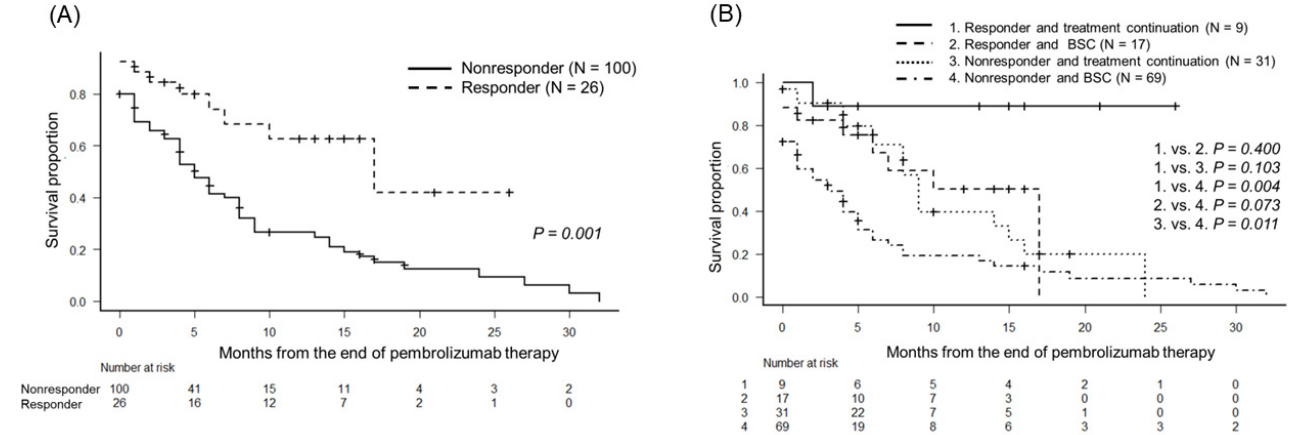
Figure 3. Kaplan–Meier estimates of overall survival (OS) in patients with metastatic urothelial carcinoma who showed tumor shrinkage (responder group) and who did not show tumor shrinkage (nonresponder group) after pembrolizumab administration. ( A ) The median OS times were 5 months and 17 months in the nonresponder and responder groups, respectively ( p = 0.001). ( B ) The enrolled patients were divided into four groups: the patients who received and did not receive third-line treatment in the responder group (groups 1 and 2, respectively) and in the nonresponder group (groups 3 and 4, respectively). The median OS times were as follows: not reached in group 1, 17 months in group 2, 9 months in group 3, and 3 months in group 4. The OS of patients in the responder group treated with third-line therapy was significantly longer than that of patients in the nonresponder group not treated with third-line therapy ( p = 0.004). In the nonresponder group, patients who received third-line treatments had significantly longer OS than those who did not receive third-line treatments ( p = 0.011).